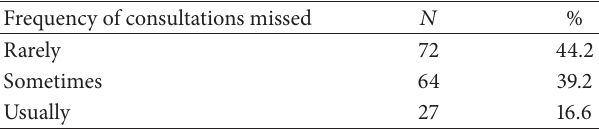
Table 4: Patient reported frequency of consultations missed ( 𝑁 = 163